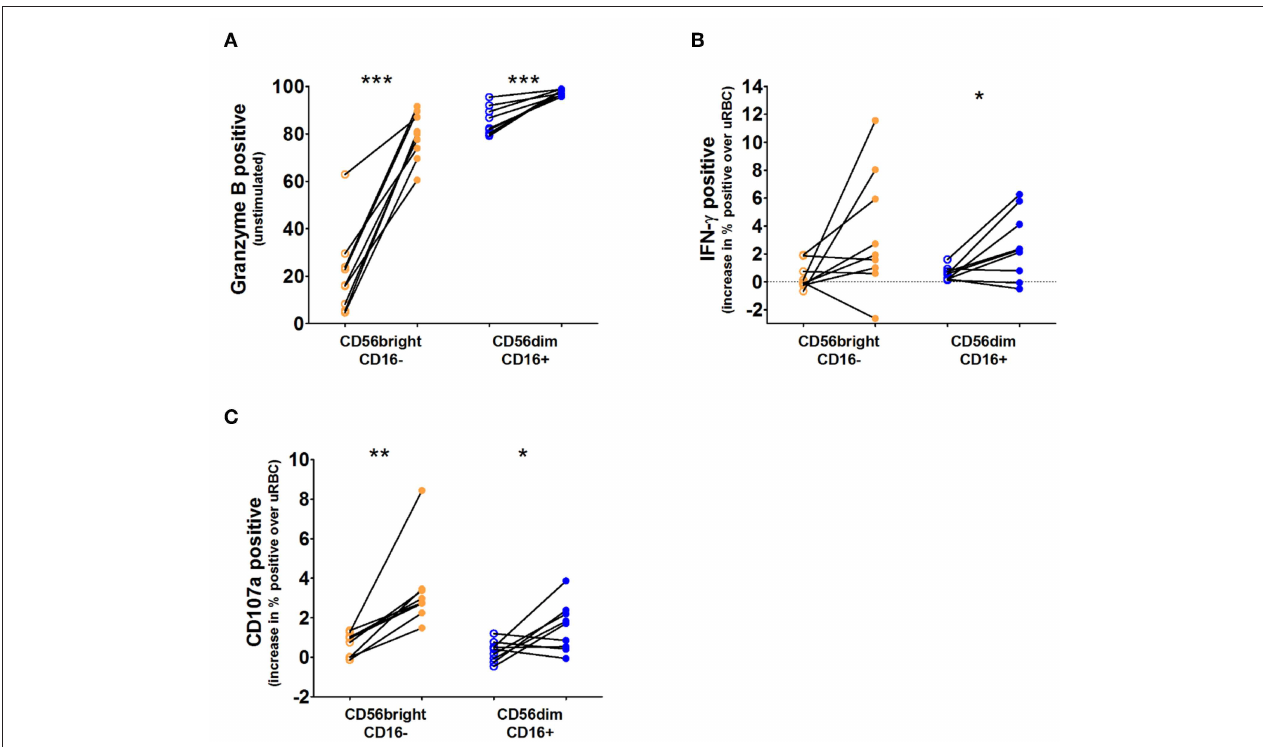
FIGURE 4 | IFN- γ , granzyme B, and degranulation responses per NK cell subset. Cryopreserved PBMCs from nine volunteers taken before challenge (open circles) and 3 days after antimalarial treatment (closed circles) were thawed and stimulated for 6h with Pf -infected red blood cells (PfRBC) or uninfected RBC (uRBC). Total NK cells were divided into two subpopulations based on their surface expression of CD56 and CD16. (A) Intracellular granzyme B content (% cells positive) determined by flow cytometry in unstimulated NK cells (those incubated with uninfected RBC cultures) at both time points. (B) Intracellular IFN- γ production (% cells positive) in response to PfRBC stimulation at both time points, IFN- γ production after PfRBC stimulation was corrected for production in response to uRBC. (C) CD107a staining (% cells positive) in response to PfRBC stimulation at both time points, CD107a staining after PfRBC stimulation was corrected for production in response to uRBC. For all three graphs open circles are pre-infection time points and closed circles are day 3 post antimalarial treatment. P -values are the result of paired samples t -test; * p < 0.05; ** p < 0.01; *** p <